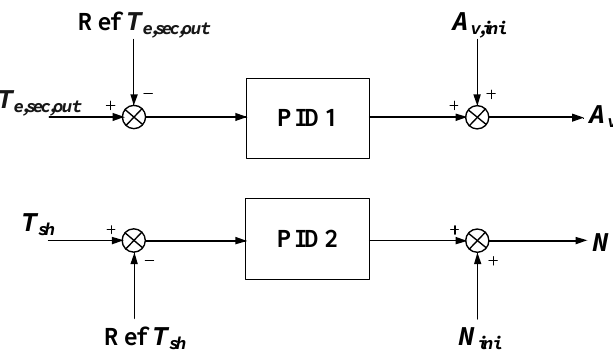
Figure 6. The structure of the controller.